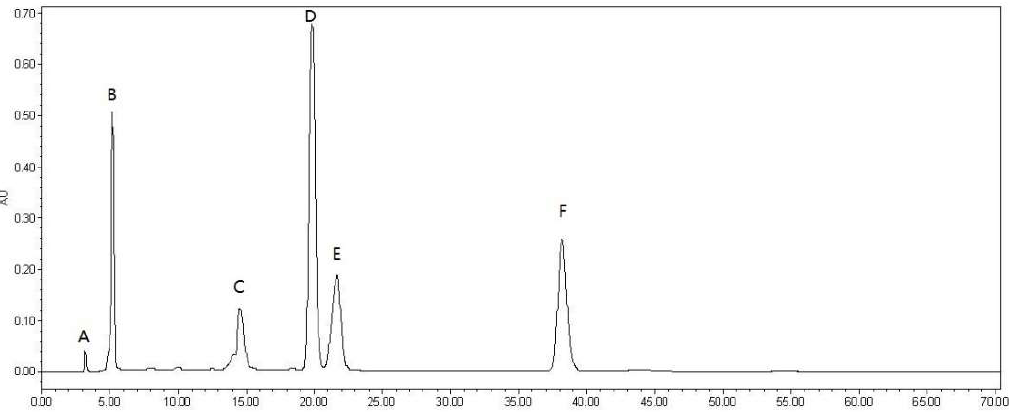
Figure 1. HPLC chromatography profile of mango peel extract (MPE). ( A –vanillic aldehyde; B –caffeic acid; C –oleanolic acid; D –chlorogenic acid; E –gallic acid; F –procyanidin B 2 ).